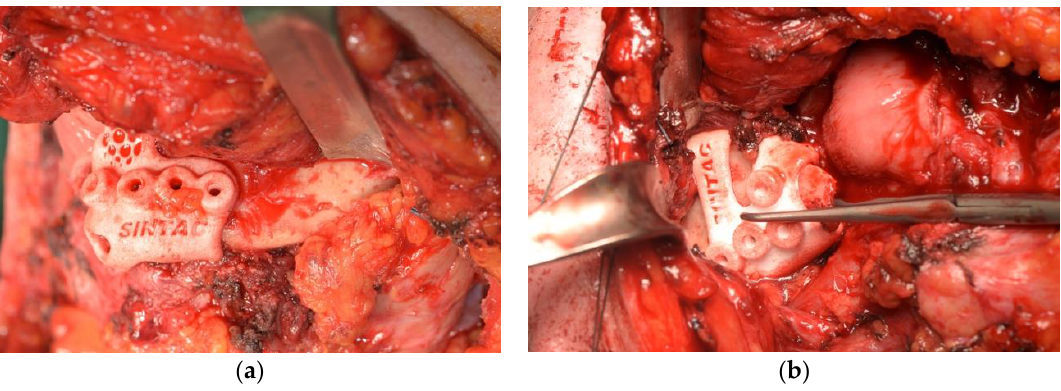
Figure 3. Positioning of cutting and drilling guide. ( a ) ramus positioning; ( b ) symphysis positioning.